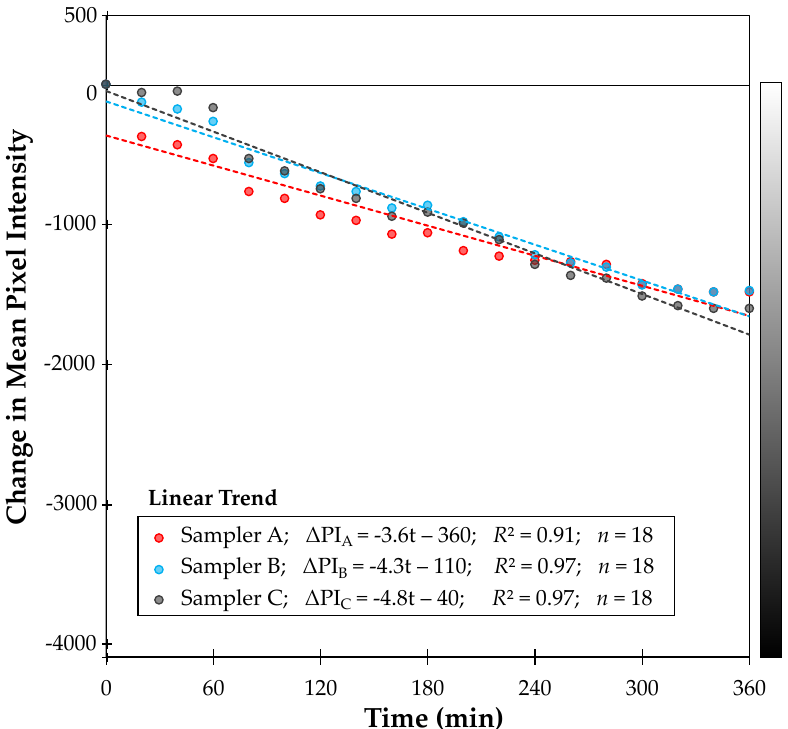
Figure A6. Linear regression models predicting changes in reflectance for three samplers (A, B, C) based on exposure time in the kerosene smoke chamber in the laboratory. Change in reflectance (measured by change in mean pixel intensity ( ∆ PI; unitless) and illustrated by grayscale) ranges from 0 (indicating no change in grayscale) to − 4095 (indicating a change in grayscale from perfect white to perfect black). Points indicate estimated change in reflectance for each sampler for each sampling time-point (18 sampling